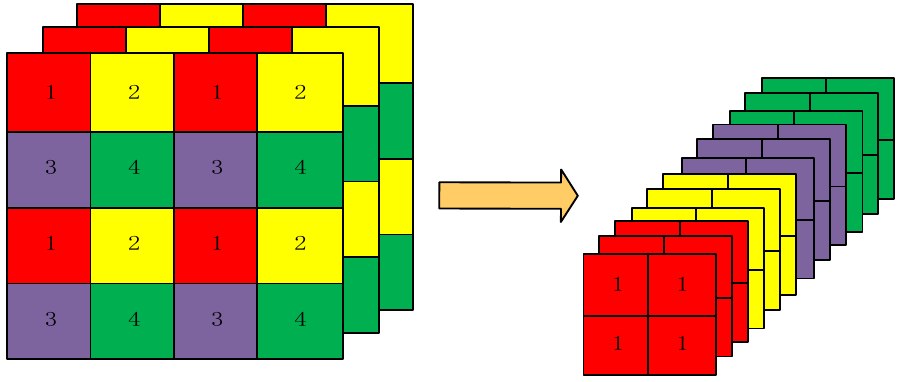
Figure 7. Slice operation.